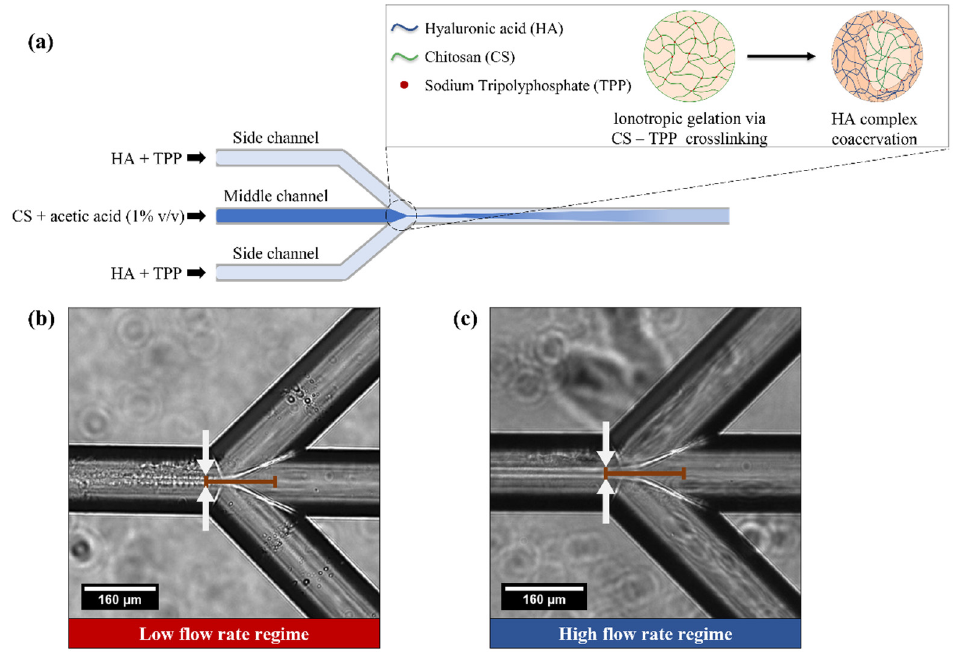
Figure 1. ( a ) Schematic representation of the hydrodynamic flow focusing within microfluidic chip. Middle and side streams lead to NPs formation through ionotropic gelation via CS-TPP crosslinking followed by HA–CS complex coacervation; ( b , c ) Optical image of the microfluidic device showing the hydrodynamic flow focusing at ( b ), low flow rate regime (middle channel flow rate < 1 µ L/min) and ( c ) high flow rate regime (middle channel flow rate ≥ 1 µ L/min). White arrows in both images indicate the width of the focusing stream, while the black line along the middle channel represents its elongation at the chip